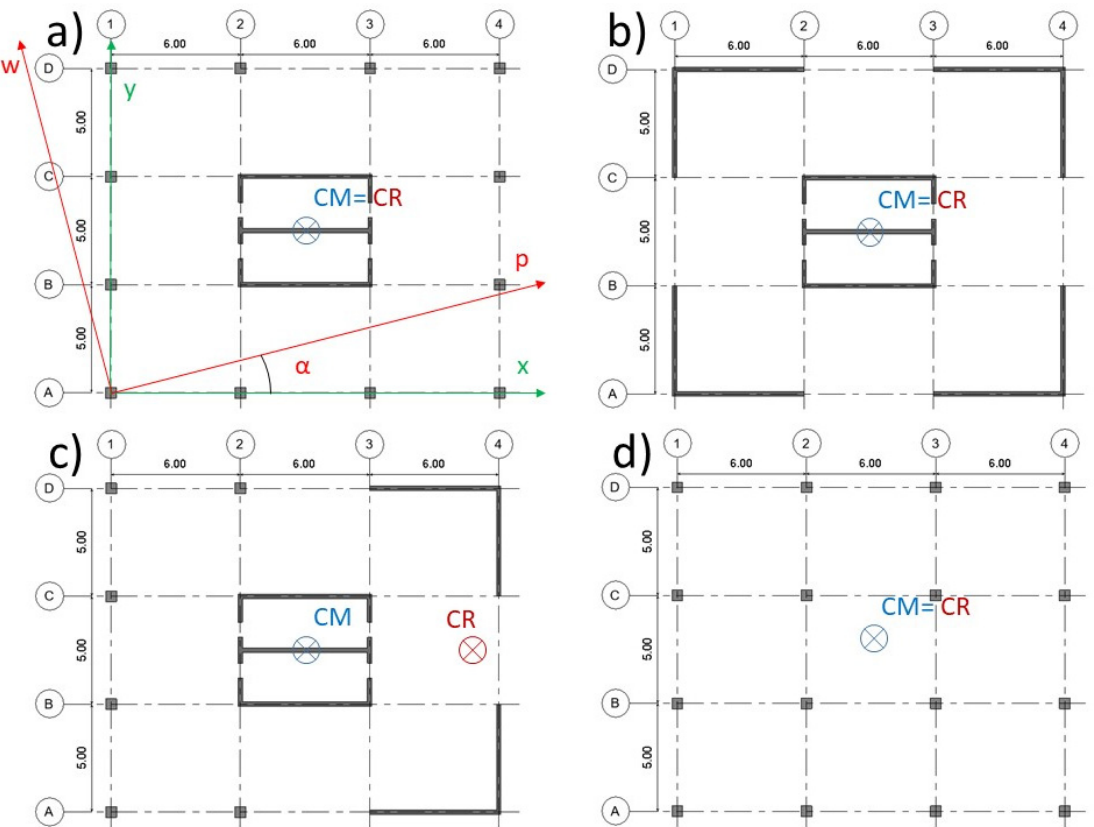
Figure 7. Plan of archetypes used for analysis of the influence of the angle of incidence: ( a ) Archetype 1 plan, torsionally flexible; ( b ) Archetype 2 plan, torsionally rigid; ( c ) Archetype 3 plan, unidirectional eccentricity; ( d ) Archetype 4 plan, flexible.